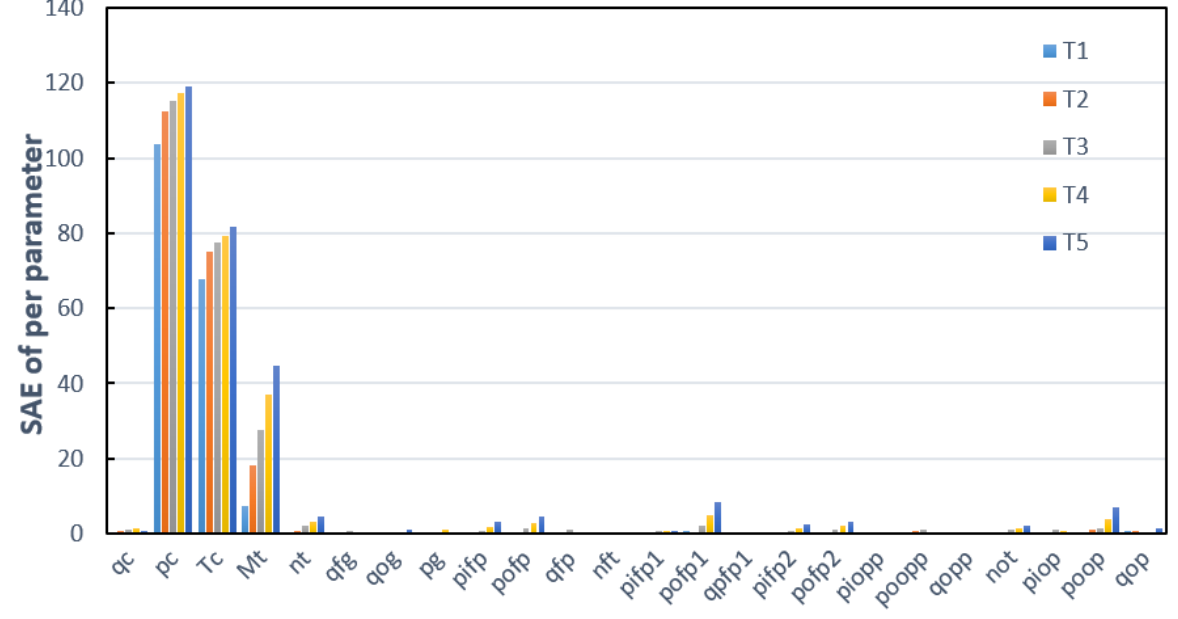
Figure 8. SAE of five consecutive samples after injection fault of test 11.